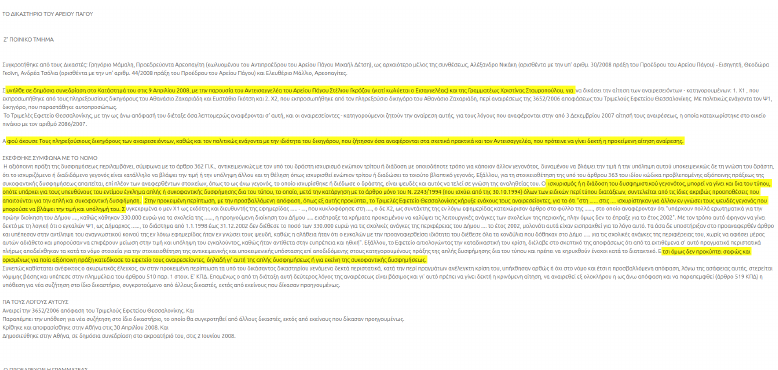
Figure 10. A screenshot of the extractive summarization evaluation in our survey. Extracted sum- maries are highlighted in bright yellow